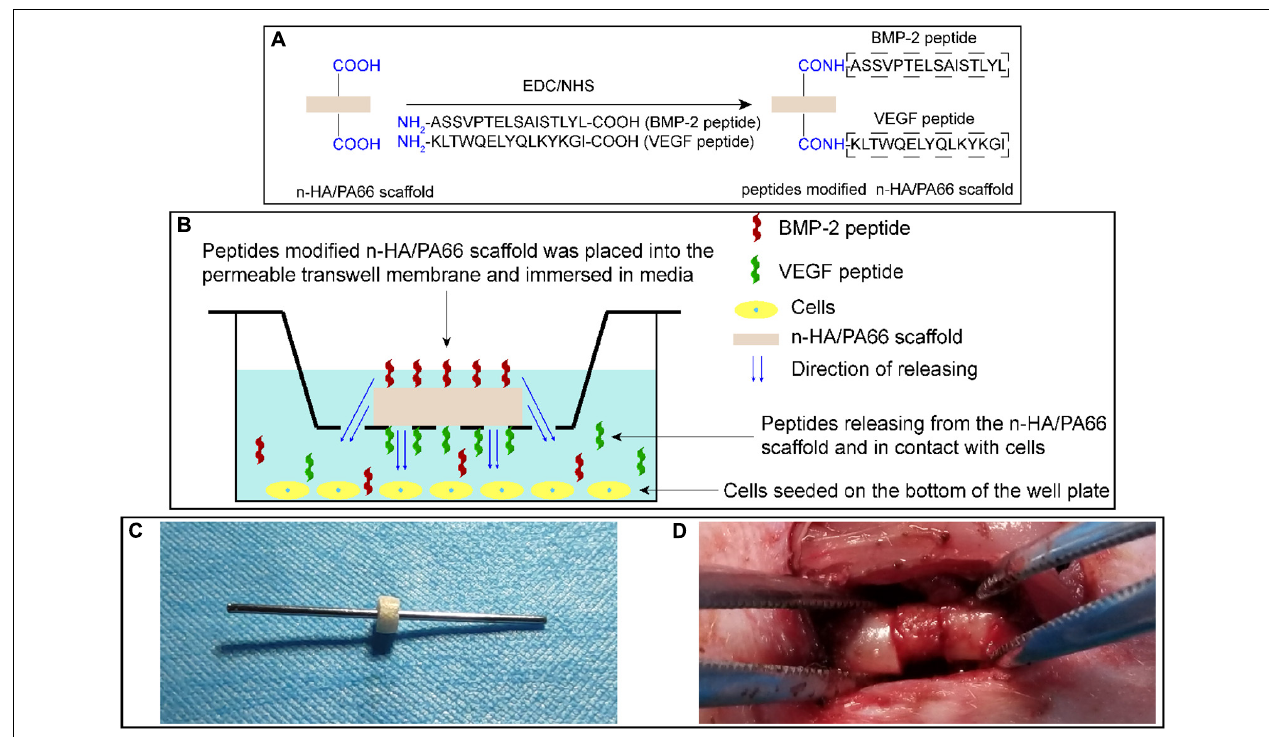
FIGURE 2 | Schematic diagrams of experimental methods. (A) Synthetic scheme of peptide-modified n-HA/PA66 scaffold via an EDC/NHS reaction. (B) Schematic representation of cell experiments to evaluate the bioactivity of peptide-modified n-HA/PA66 scaffolds. (C) Images of a Kirschner wire inserted into the hollow n-HA/PA66 scaffold, and (D) surgical procedure of previously prepared scaffold with a Kirschner wire implanted at the fracture site of femur.